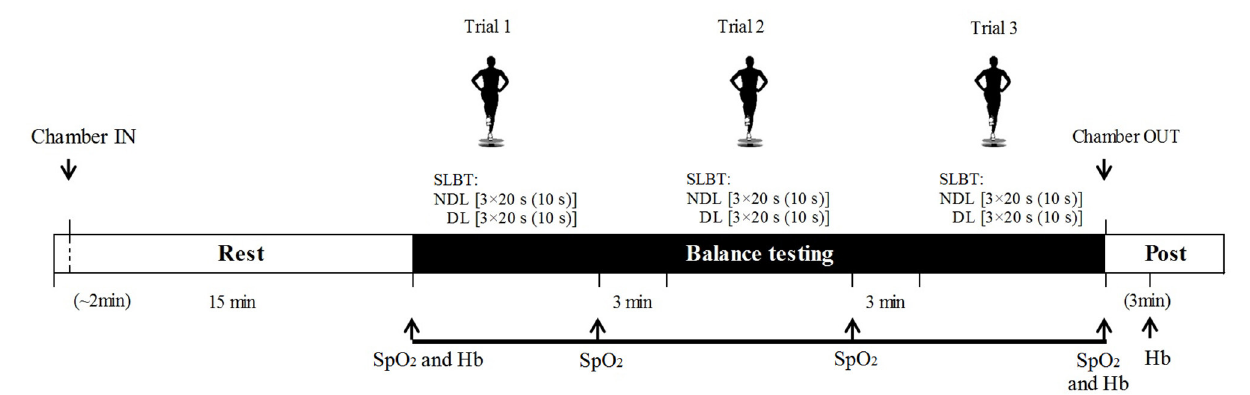
not significantly different between HYP and NOR trials ( P = 0.21). The temperature controller was set to 20 ◦ C for all